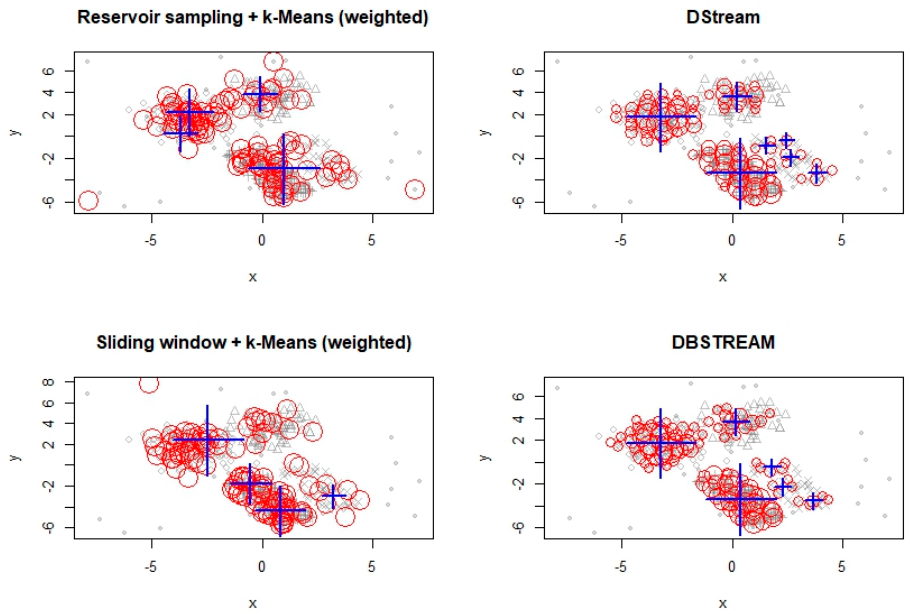
Figure 5. Macro-cluster placement for different data stream clustering algorithms.